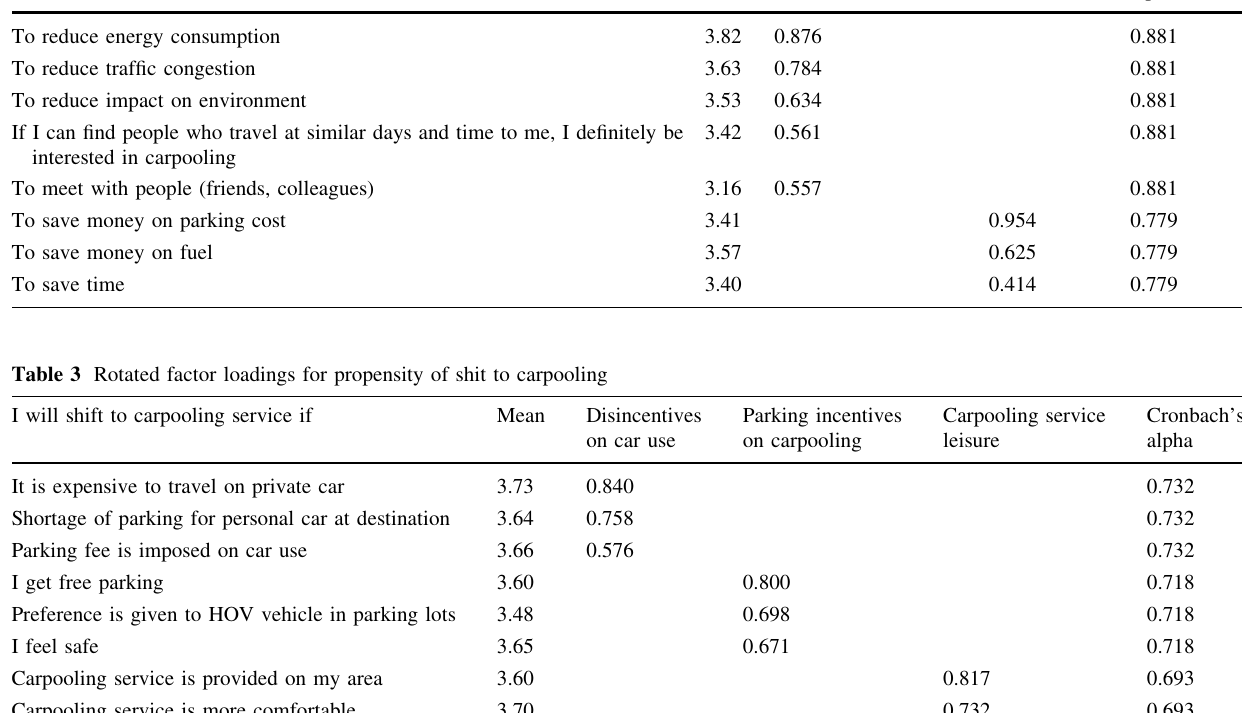
Table 2 Rotated factor loadings for benefits of using carpooling Description of benefits using carpooling